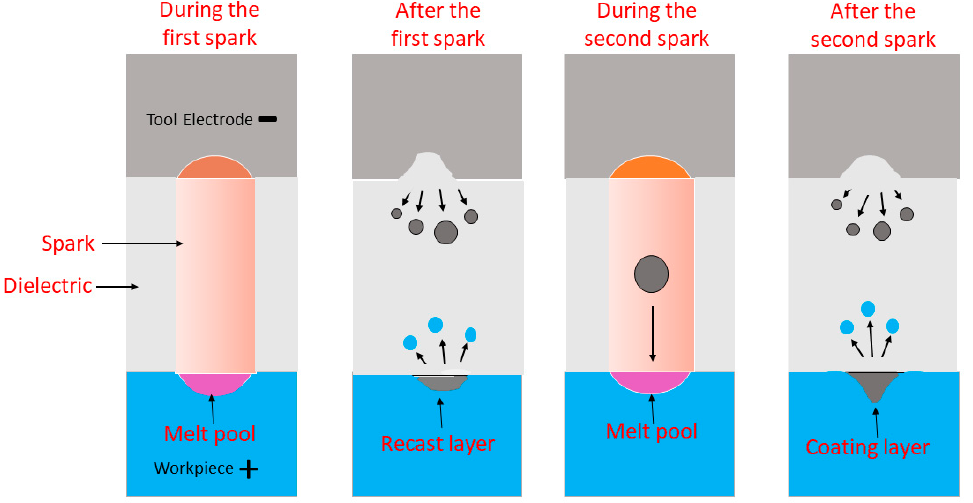
Figure 5. Mechanism of material transfer